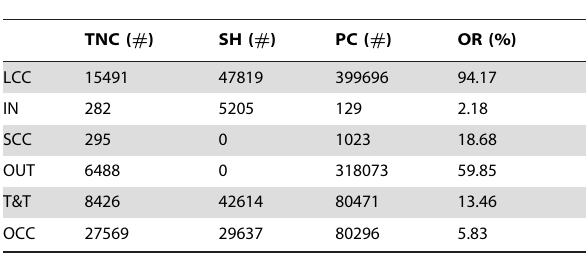
Table 1. Bow-tie